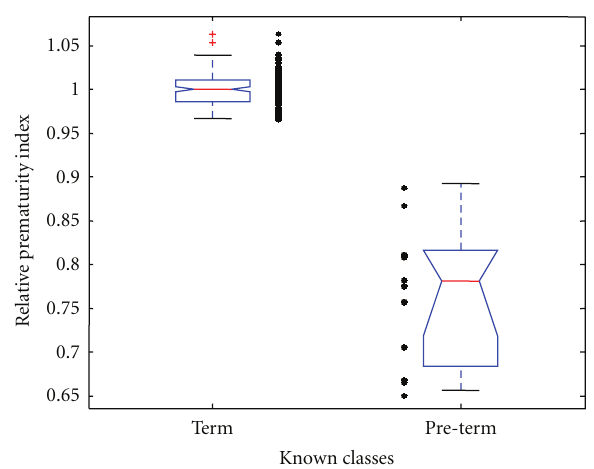
Figure 2: Box plots comparing the prematurity index for term and preterm